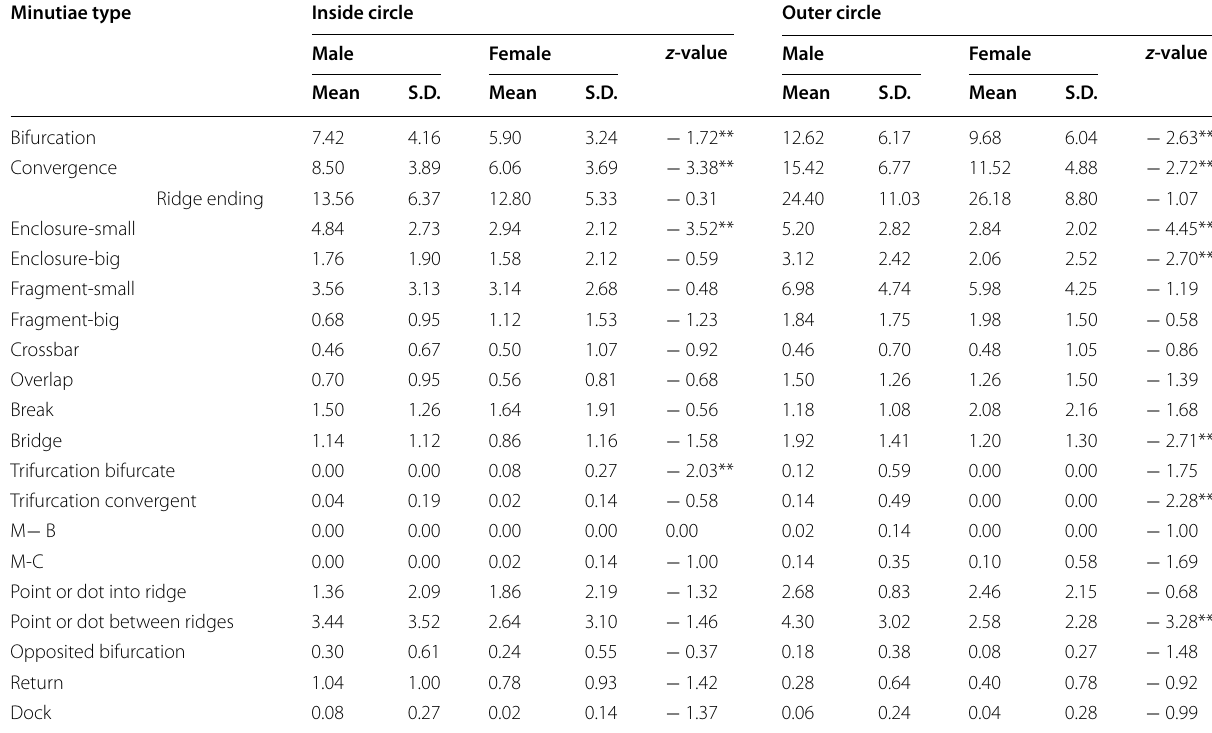
Level of significance p < 0.01**, p < 0.05*